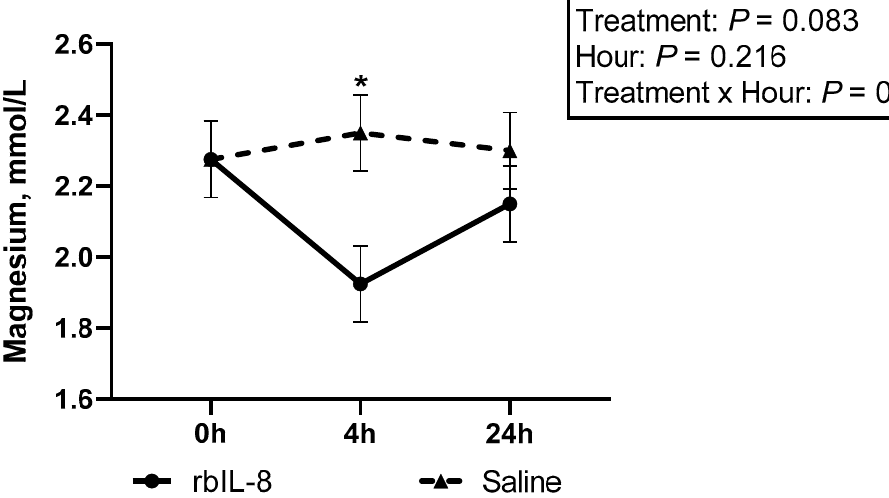
Figure 11. Circulatory concentrations of magnesium between the infused groups in hours relative to treatment. Significant time point differences ( p < 0.05) between groups are represented with an asterisk